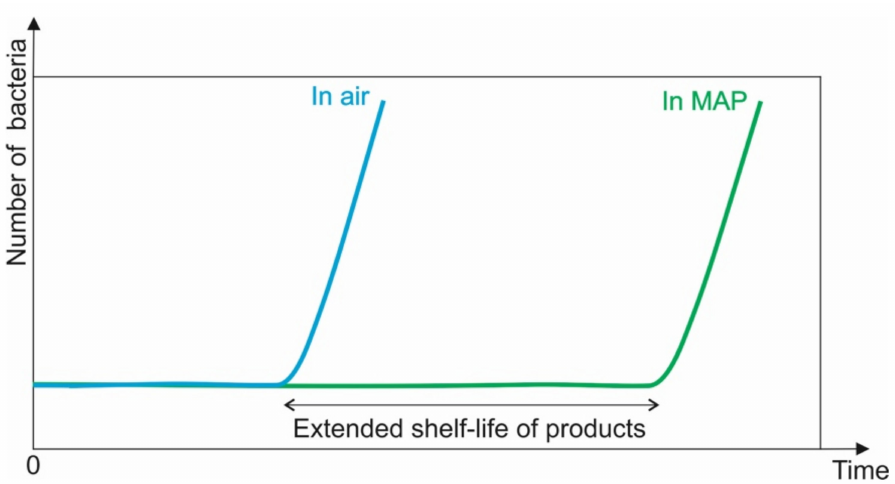
Figure 1. The difference between shelf-life of products with and without MAP gases, reprinted with permission from WITT Polska.